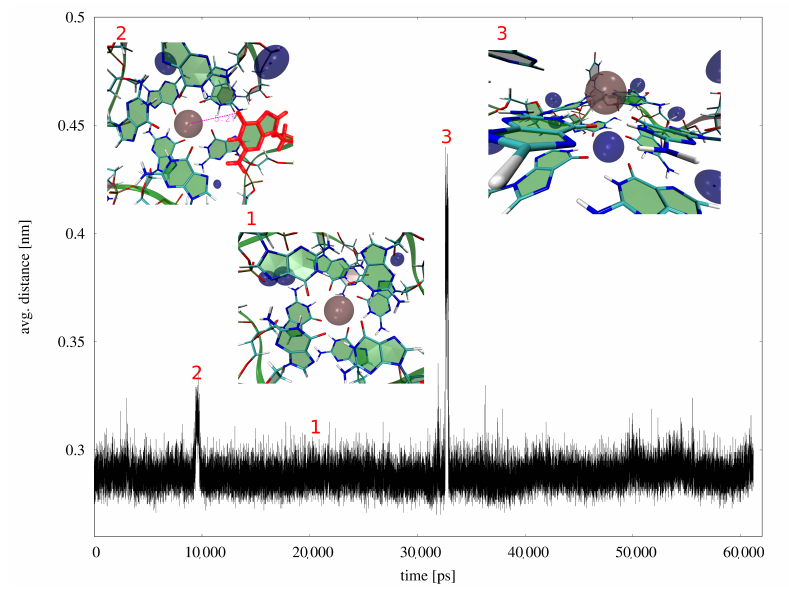
Figure A5. The stability of the seq3 quadruplex, as expressed with the average distance between the central K + and the carbonyl oxygens of the eight coordinating guanines. Inlet 1—the stable GQ core structure. Inlet 2—one of the guanines (red) dissociated from the central K + (dark-pink sphere) transiently, losing hydrogen bonding with the rest of the tetrad. Inlet 3—K + was pushed out of the GQ core by Na + (dark-blue sphere below K + ) for ∼ 300 ps.